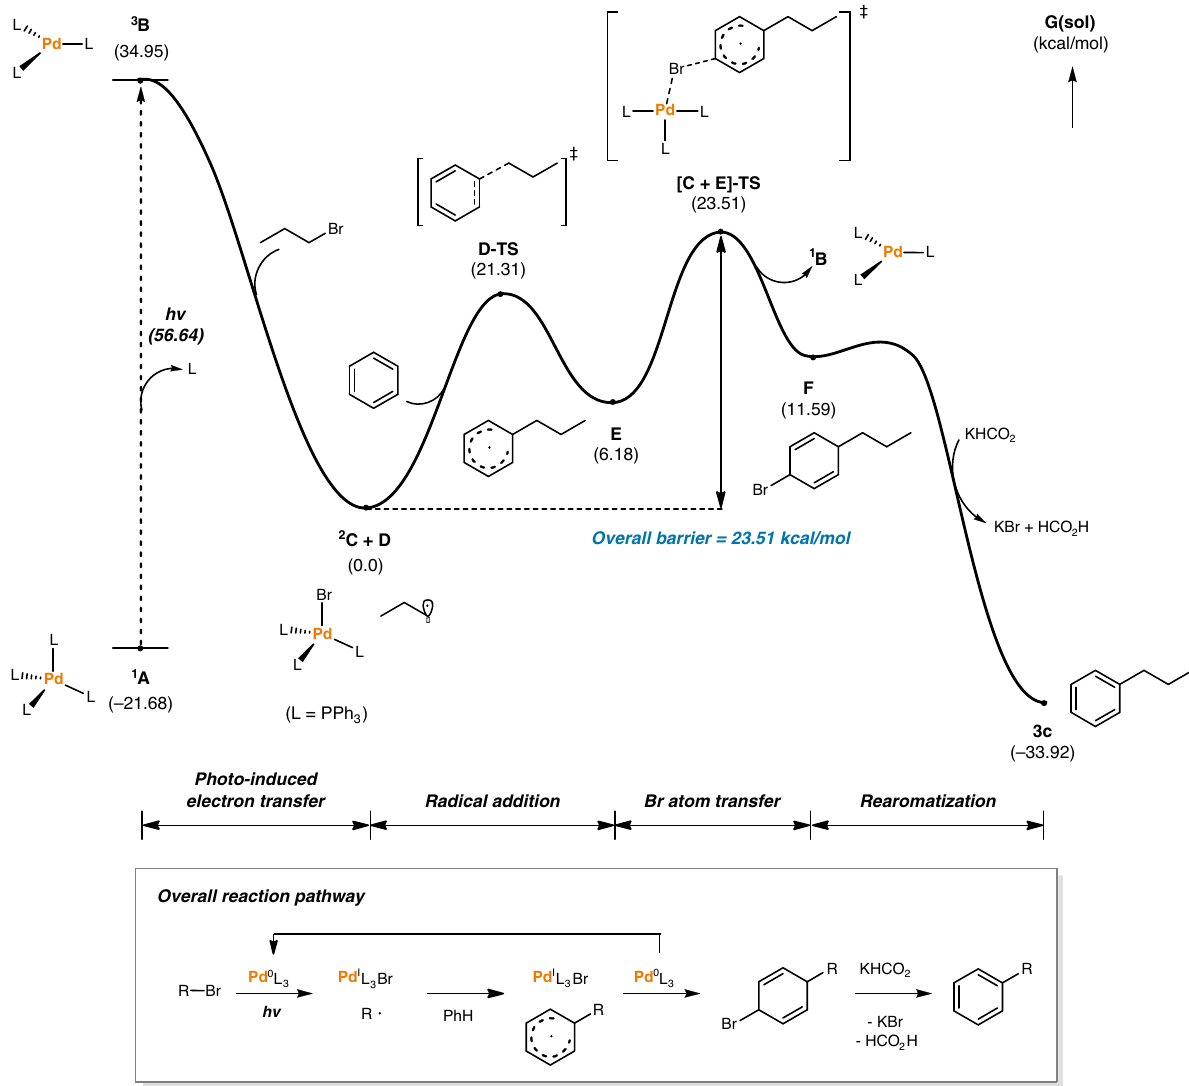
Fig. 6 Computed energy pro fi le of the proposed mechanism. Free energies in solution (in kcal/mol) at the B3LYP-D3(IEFPCM)/SDD/6-311 ++ G**// B3LYP-D3/LanL2DZ/6-31G** level are